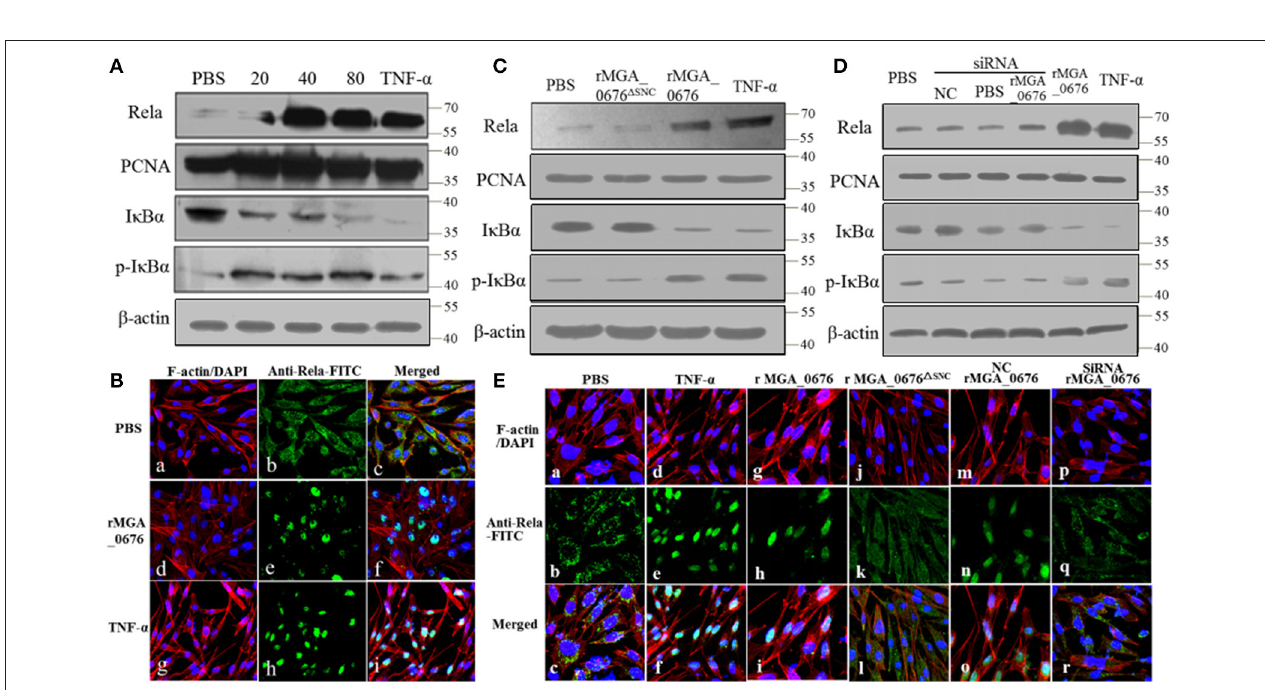
FIGURE 6 | NF- κ B is activated via interaction between MGA_0676 and NAE. (A) rMGA_0676 activated NF- κ B in DF-1 cells were detected by western blot. The activity of NF- κ B is rMGA_0676 dose dependent in DF-1 cells. DF-1 cells were treated with PBS or different doses of rMGA_0676 at 37 ◦ C. Twenty-four hours after